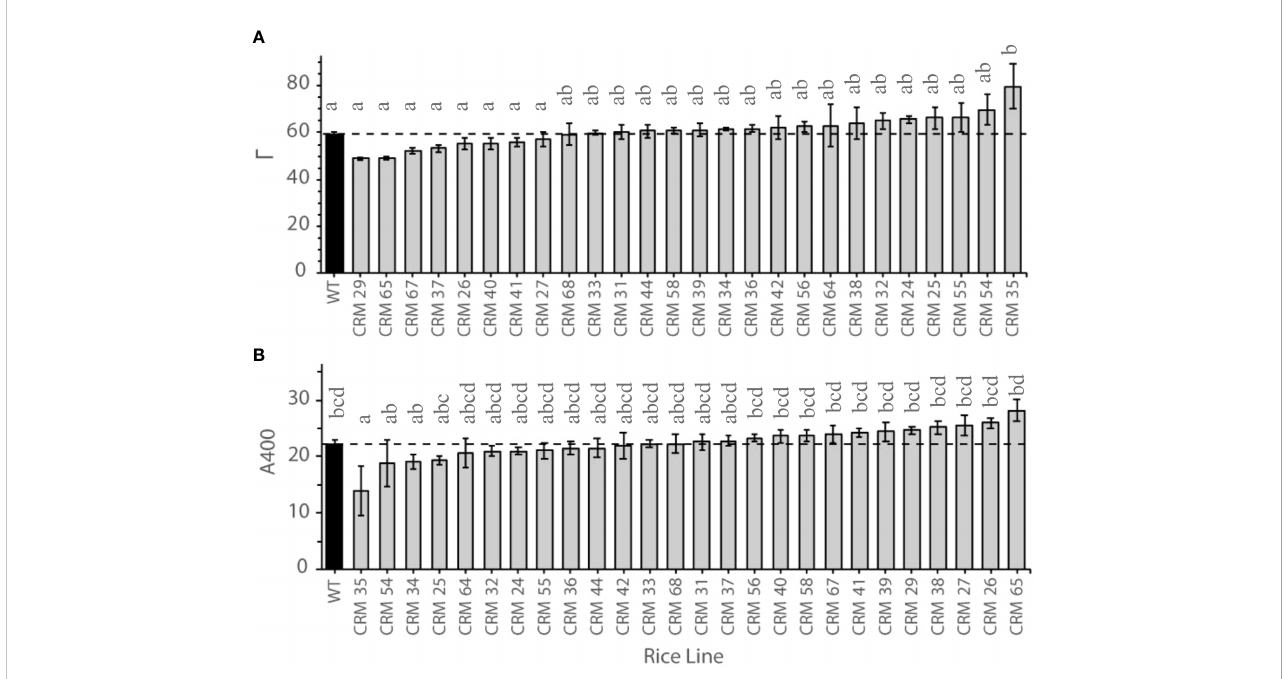
FIGURE 1 Photosynthetic traits of select Chlorophyll Retention Mutants (CRMs; grey) versus the parental wild type (WT; black) IR64, where the dotted lines indicates the WT level. (A) Mean CO2 compensation points (G) of 8th leaf in CRM mutant lines. Photosynthetic measurements were made on at least 3 plants per line. Twelve WT plant responses were included. Values are means and error bars represent standard error of the means. n.3. (B) Photosynthetic rate at ambient CO2 (A400) of 8th leaf in CRM mutant lines. Photosynthetic measurements were made on at least 3 plants per line. Twelve WT plant responses were included. Values are means and error bars represent standard error of the means. n.3. Letters indicate differences according to post-hoc Bonferroni